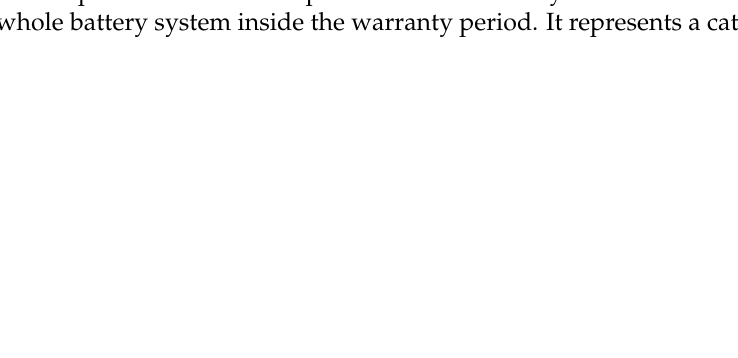
Figure 3. Proposed color map of the remaining useful warranty.